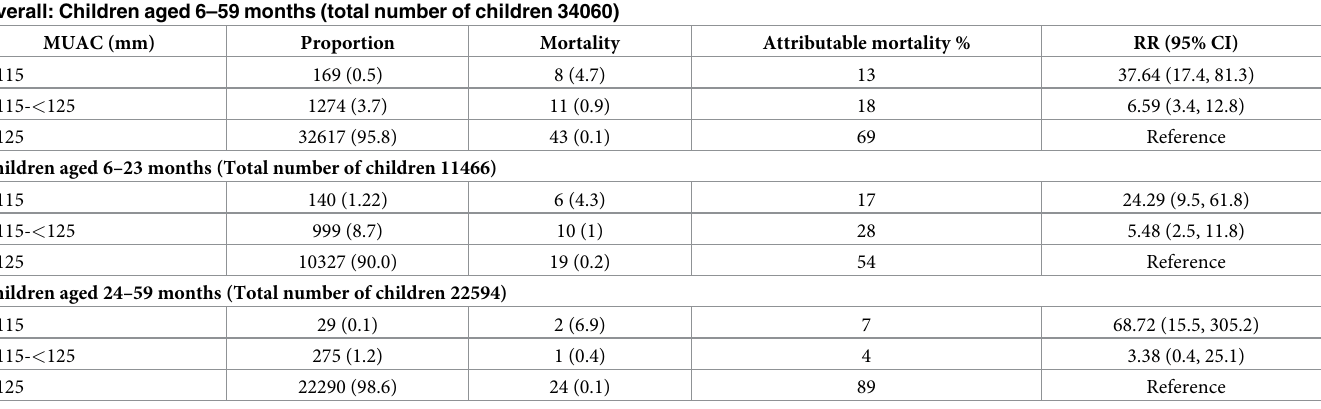
Table 1. Mortality, attributable mortality and risk of mortality in children aged 6–59 months over a 12 month period following initial MUAC measurement by MUAC category. Overall: Children aged 6–59 months (total number of children